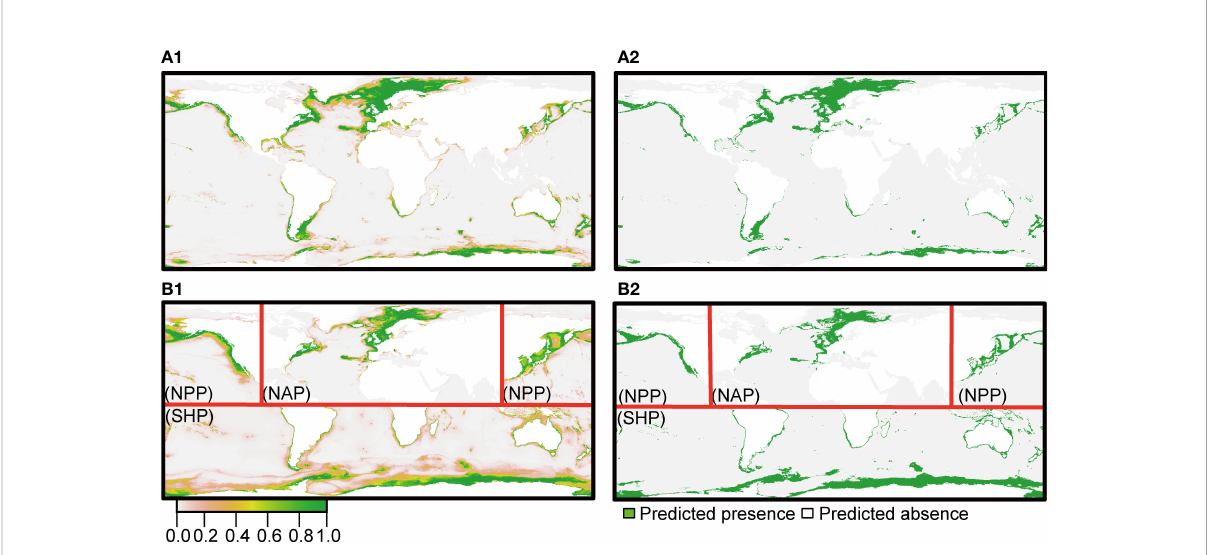
FIGURE 7 The predicted potential distribution under the current environmental conditions based on models built at the species level (A1, B1) and population level (A2, B2) . The continuous habitat projections (A1, A2) were converted into binary (0/1) projections by using automatically generated thresholds that maximized the TSS values of the ensemble models. The red lines in A2 and B2 represent the boundaries among the three populations.